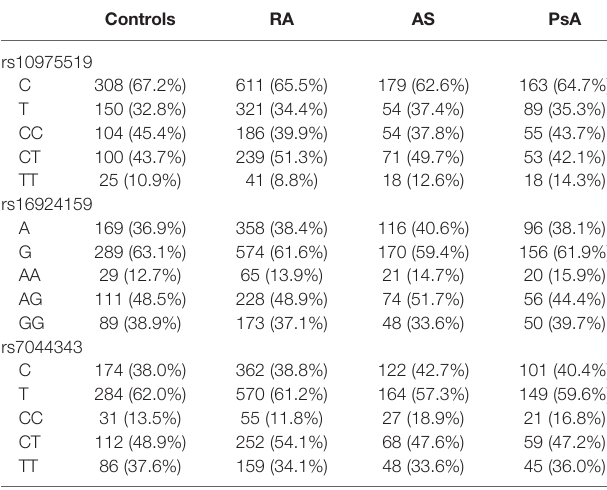
TABLE 3 | Comparison of the IL-33 genotypes and alleles frequencies between patients diagnosed with rheumatoid arthritis, ankylosing spondylitis, psoriatic arthritis, and healthy